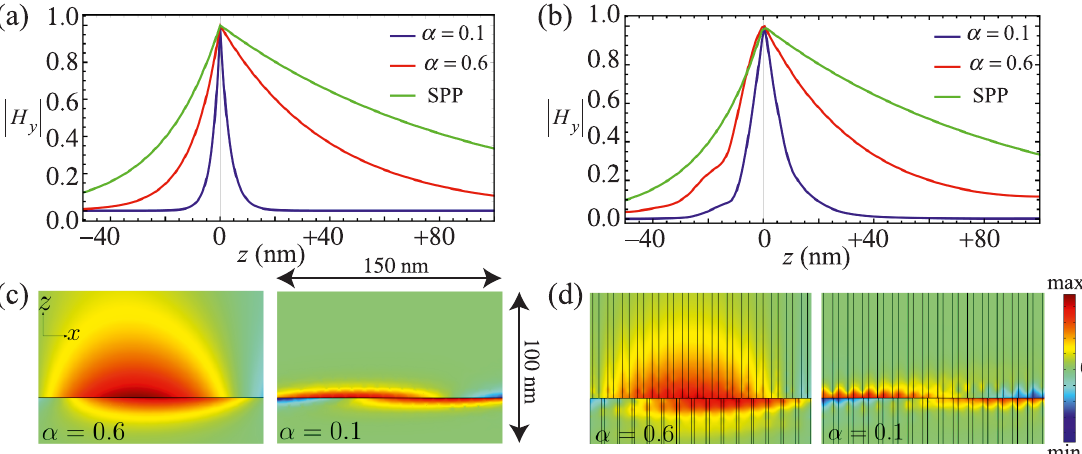
Figure 4: (a) Modulus of the magnetic field for the interface plasmon calculated in the effective medium approximation at k x = 2.26 × 10 7 m − 1 compared to a surface plasmon that exists between a pure metal and pure vacuum at the same frequency. (b) The same calculation but now deploying COMSOL on the metamaterial structure, lattice spacing a = 10 nm. (c) An effective medium calculation of the magnetic fi eld distribution plotted in the vicinity of the interface. (d) The same calculation but now deploying COMSOL on the metamaterial structure and plotted in a plane taken through the centre of the cylinders. The surface mode is excited by a surface current along the x -direction at the interface, which makes the magnetic fi eld